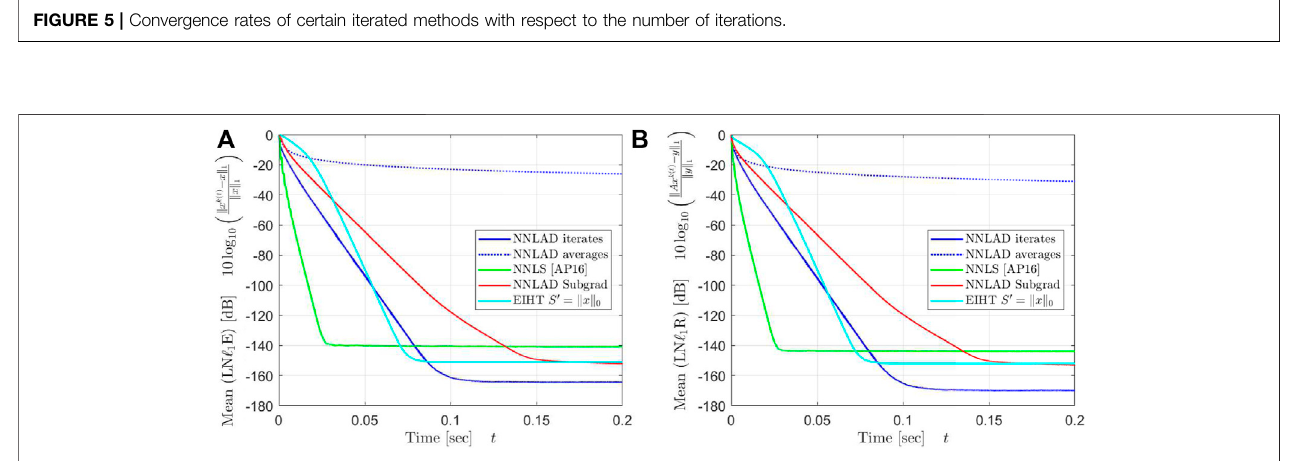
FIGURE 6 | Convergence rates of certain iterated methods with respect to the